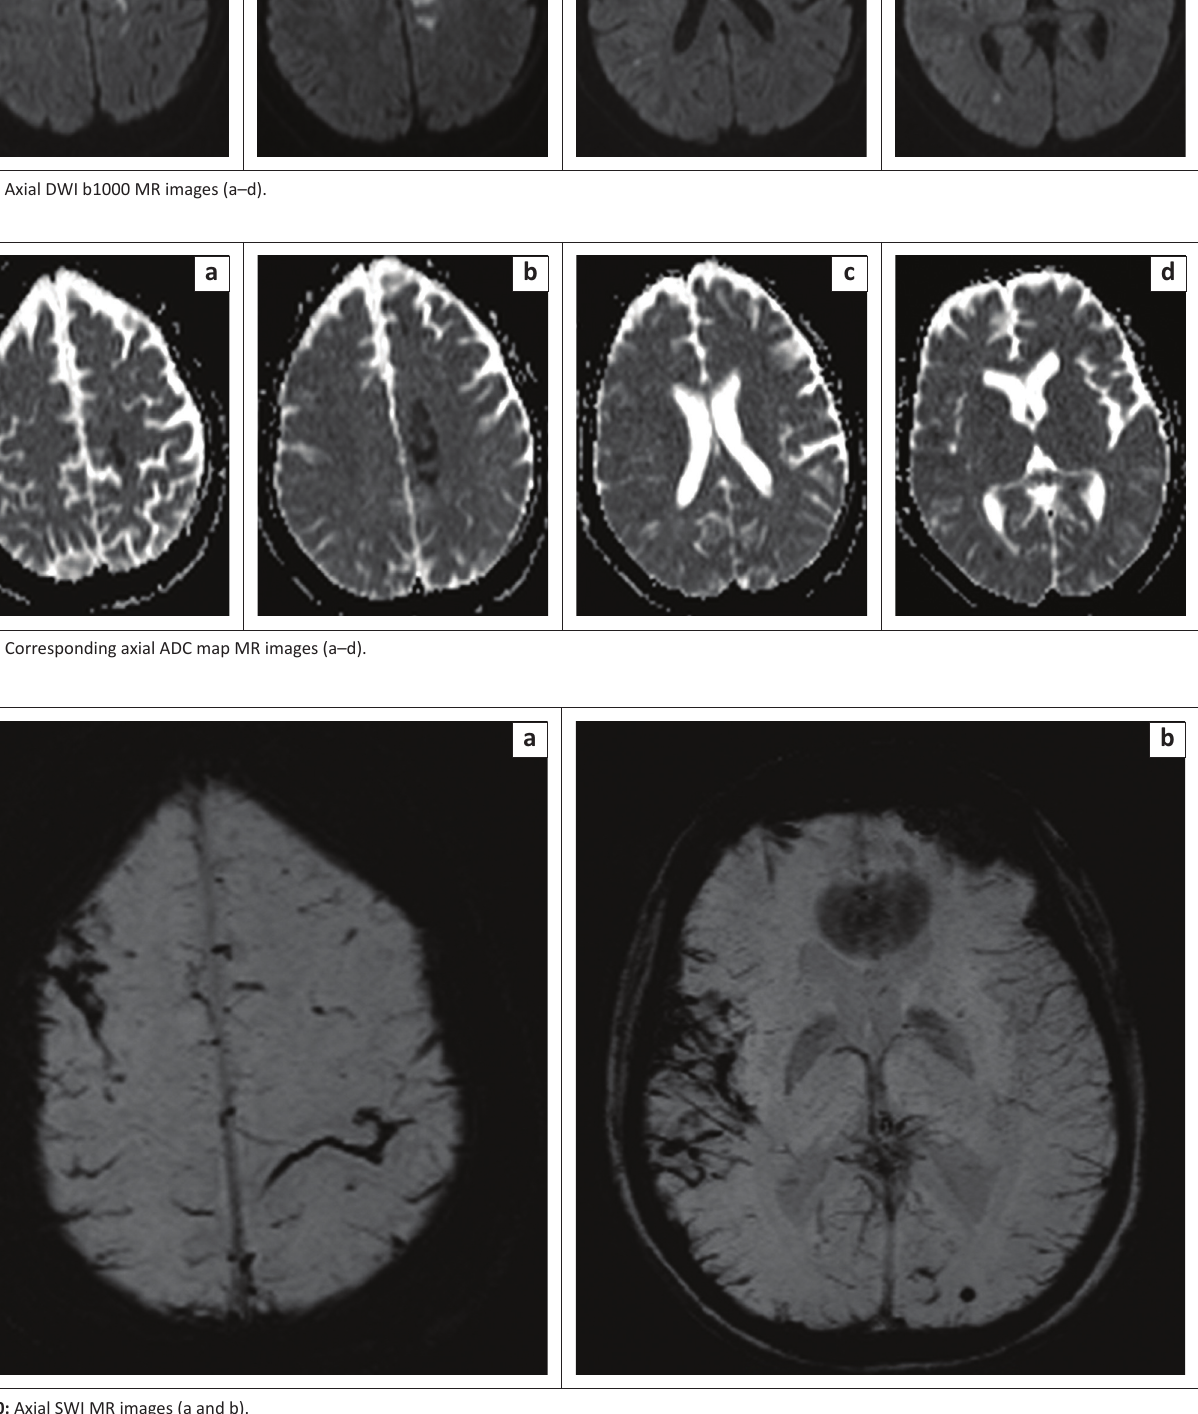
FIGURE 10: Axial SWI MR images (a and